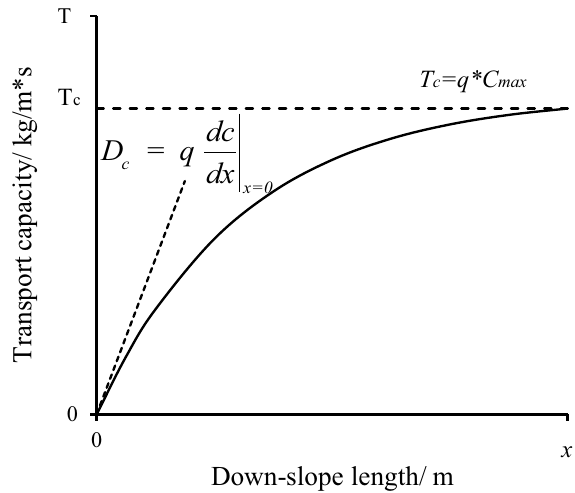
Figure 1. Calculation principle of transport capacity ( T c ) and detachment capacity ( D c